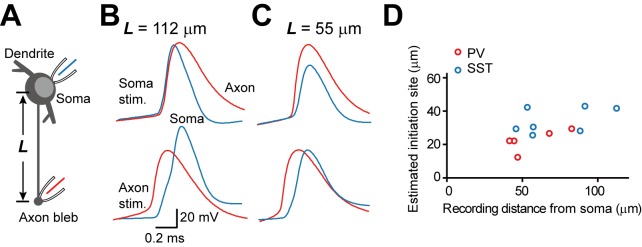
Estimation of AP initiation site at the AIS of PV and SST neurons.(A) Schematic diagram of simultaneous recording from the soma and the axon bleb. (B) Example recording from a PV neuron with an axon bleb formed 112 µm away from the soma. APs evoked by current injections at the soma (top) or axonal bleb (bottom). When the soma was stimulated, somatic AP generated earlier than axonal AP; in contrast, when the axon bleb was stimulated, axonal AP occurred earlier. (C) Similar to (B) except that the recording distance was 55 µm. Note that axonal APs preceded somatic APs in both conditions. (D) The estimated initiation sites (see Materials and Methods) in PV were more proximal than that in SST neurons.